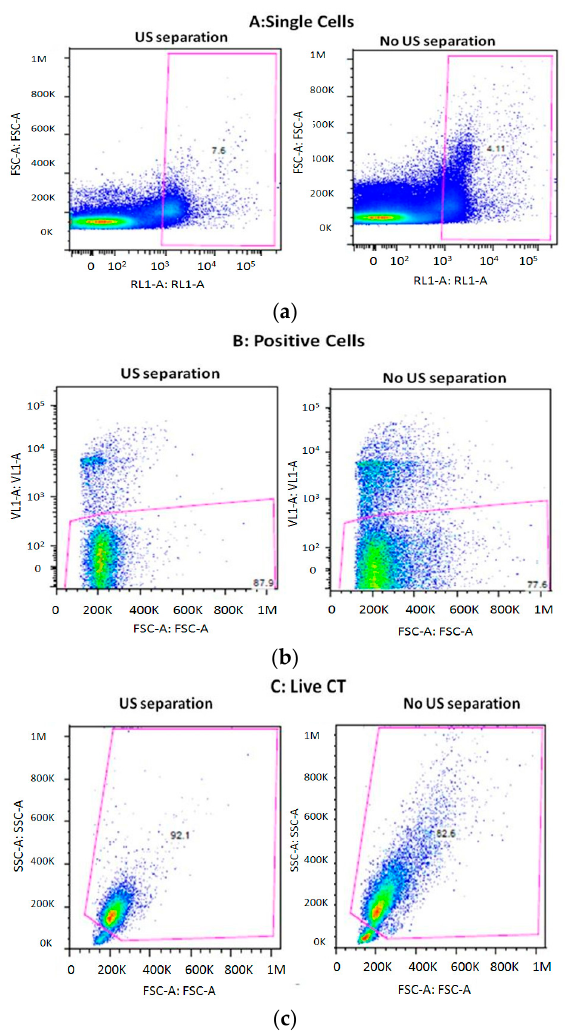
Figure 7. Analysis of cell viability by flow cytometry with and without US chip cell separation . ( a ) Single non-aggregated cells were first selected for using FSC-Area (FSC-A) versus FSC-height, and DilC18-stained TC cells were then identified by excitation with a red laser and emission capture at 440/50 nm (RL1-A). ( b ) Within the DilC18-positive TC population, DAPI-negative cells (i.e., live cells) were determined by excitation with a violet laser and emission capture at 670/14 nm (VL1-A). ( c ) Size and complexity analysis of live cells using SSC-A versus FSC-A.